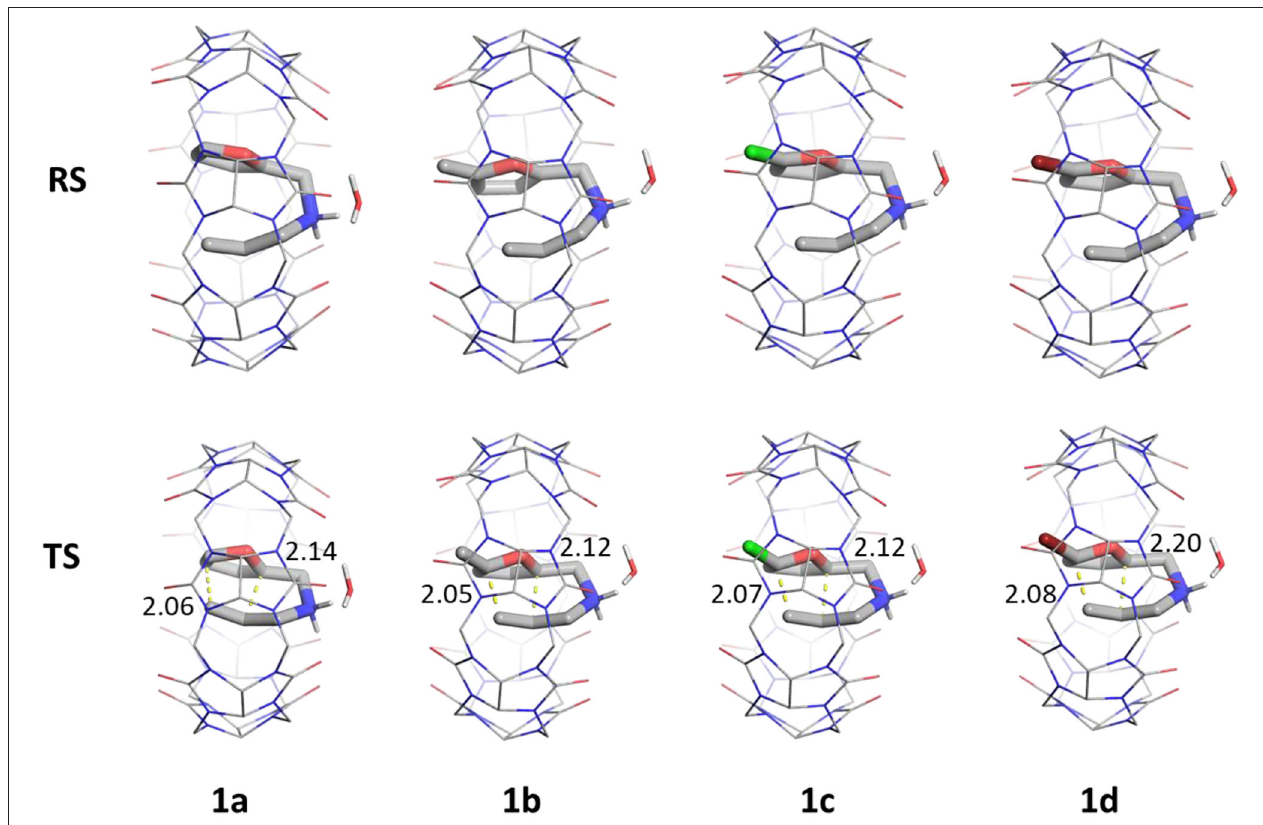
FIGURE 7 | Reactant complexes (RS, top) and transition states (TS, bottom) of ligands 1a–d in the presence of CB[7] (lines) and a single explicit water. Distances of C-C outer (left) and C-C inner (right) are shown in Å. Non-polar hydrogens are hidden for clarity.